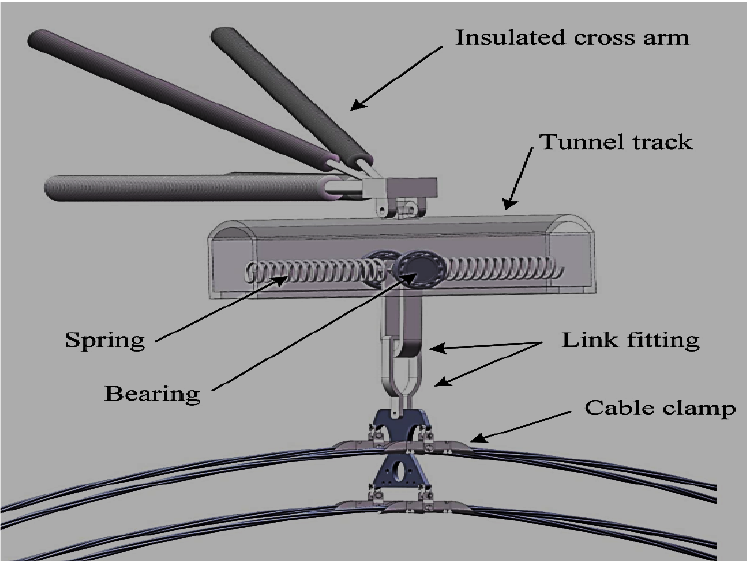
Figure 29. Design diagram of new sliding point device [97].